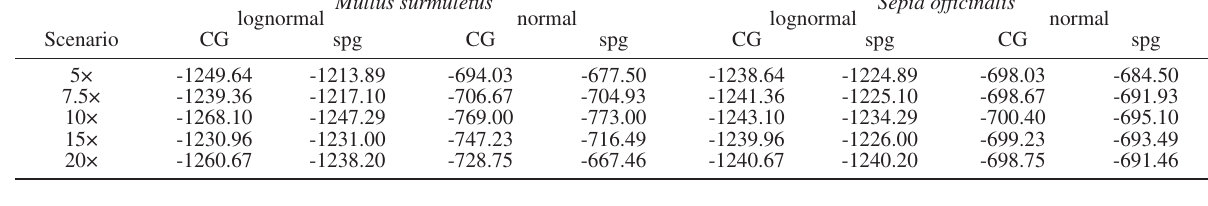
Table 1. – Akaike Information Criterion values under different conditions of starting values for N (5 to 20 times the maximum observed catch 0 value in numbers) corresponding to different algorithms (CG and spg) and error distributions (lognormal and normal) used in the fit of the multi-annual general depletion model.